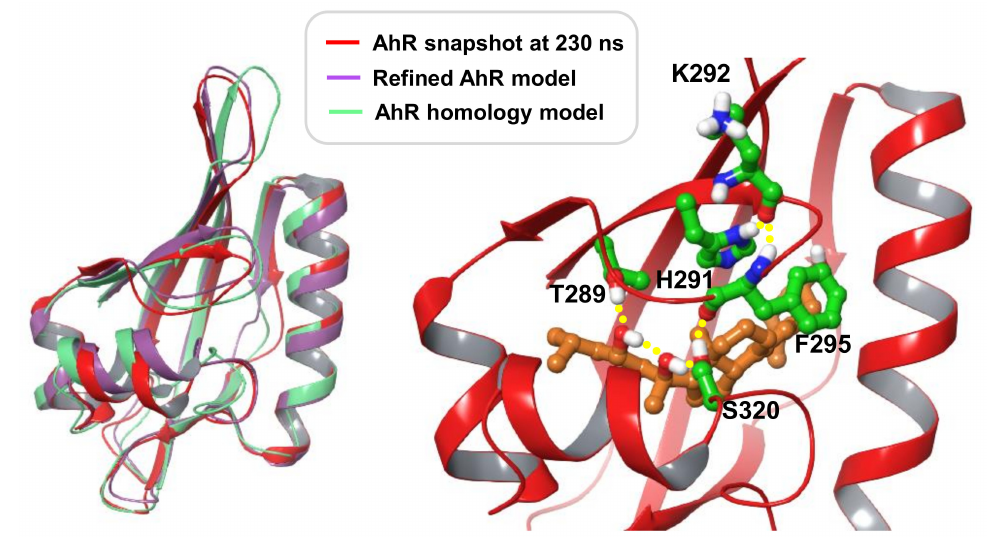
Figure 7. Structural fold of AhR models. To the left: Superimposed are the initial homology model, the refined AhR model and a molecular dynamic simulation snapshot at 230 ns. To the right: Close-up view of the simulation snapshot at 230 ns, displaying the ligand and AhR residues involved in an interaction network, as discussed in the text. 20 S ,23 S (OH) 2 D3 is shown with carbon atoms colored light brown, AhR residue carbons colored green; all other atoms are colored by atom type (O: red, N: blue, S: yellow). Hydrogen bonding interactions are indicated with yellow